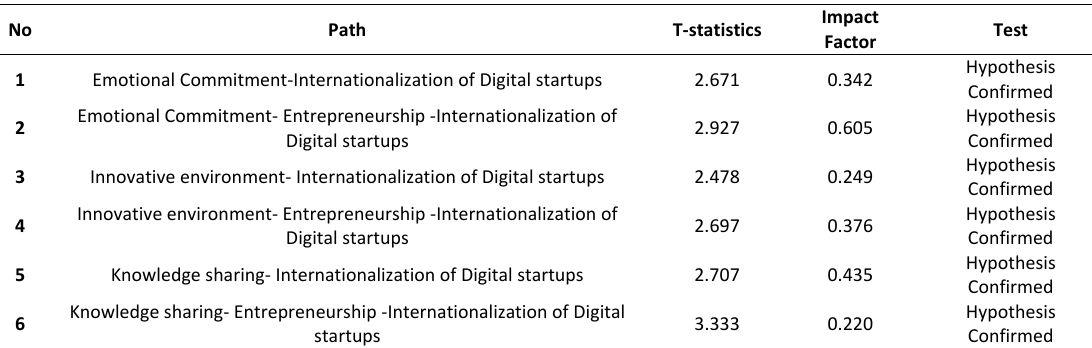
Table 4. T‐statistics and research impact factor Table 4. T-statistics and research